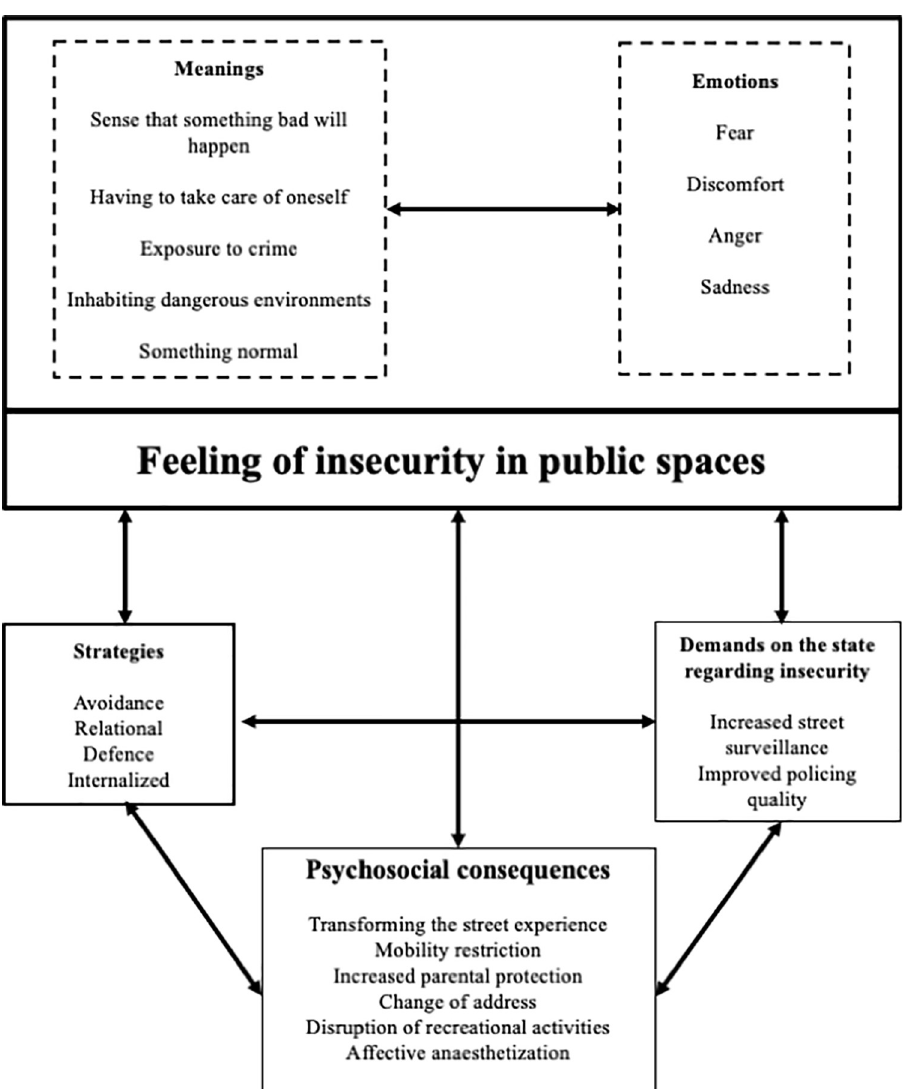
Fig 3. Components of the feeling of insecurity in public spaces and psychosocial consequences. Source: Own